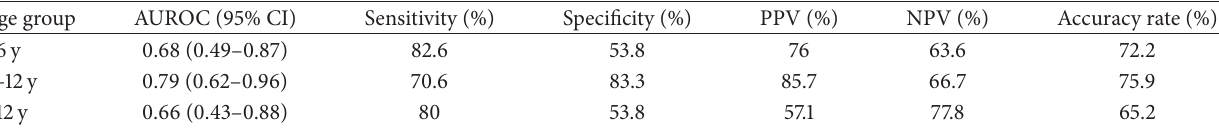
Table 3: The predicative value of APRI for significant inflammation ( ≥ G2; cut-off =